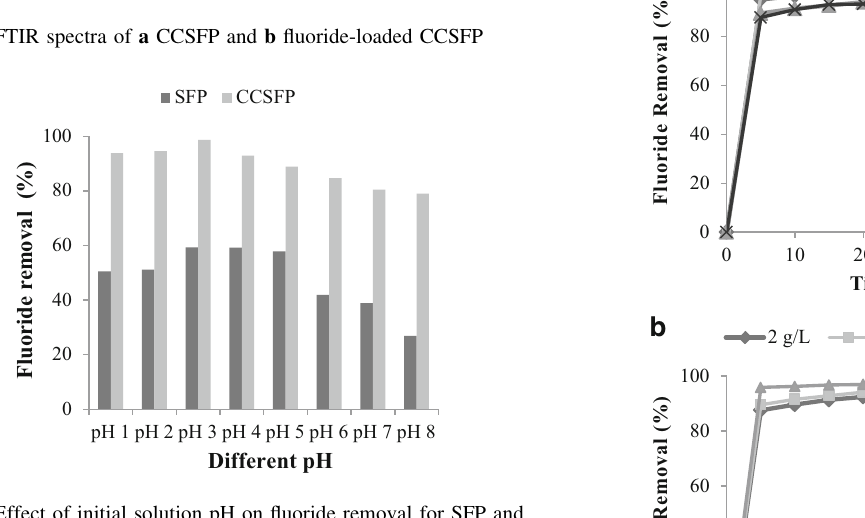
Fig. 5 Effect of initial solution pH on fluoride removal for SFP and CCSFP